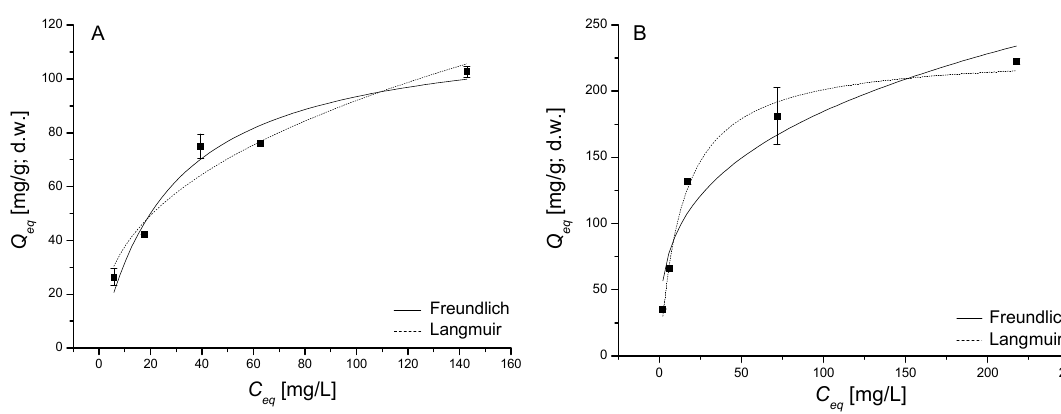
Figure 5. Fit of the Langmuir and Freundlich isotherms of thioflavin T (TT); ( A ) and methylene blue (MB); ( B ) sorption by dried biomass of freshwater moss V. dubyana ( C B = 0.5 g/dm 3 ) from single sorption systems after 2 h interactions at 25 °C and pH 6.0. Table 3. Comparison of Q max values of different sorbents determined from Langmuir isotherm for TT and MB.